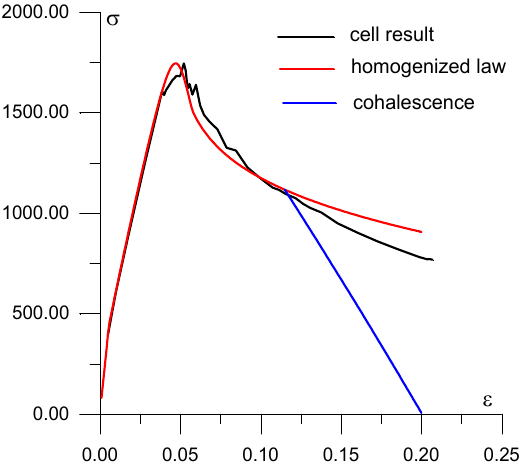
Figure 7: Global cell response compared with eq. (1) and the coalescence